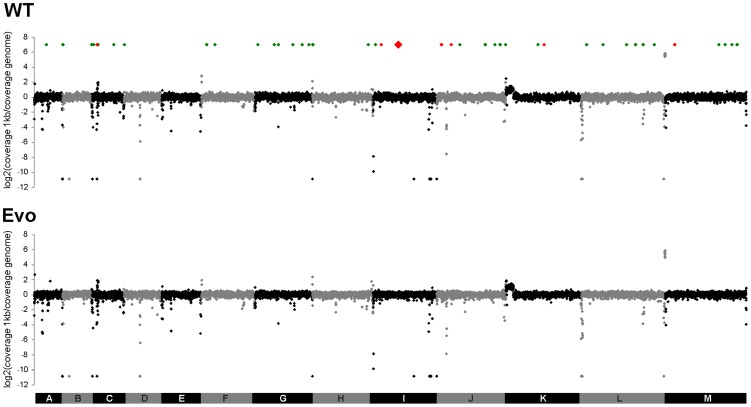
No large-scale genomic changes, but single SNP differences can be detected between WT and Evo strains.Following alignment of Solexa/Illumina reads for the genomes of strains ATCC2001 and Evo on the C. glabrata reference genome, an average coverage score was calculated for each 1 kb region and normalized to the coverage obtained across the whole genome. These coverage ratio are shown in log2 scale. C. glabrata chromosomes A to M are shown in alternating black and grey colors. The location of SNPs identified in both strains relative to the reference genome is shown with green diamonds. The location of SNPs that distinguish the two strains is shown with red diamonds, the SNP on chromosome I responsible for the phenotype of strain Evo being shown in larger size. Note that several 1 kb regions harbored more than one SNP and are nevertheless represented using a single diamond.